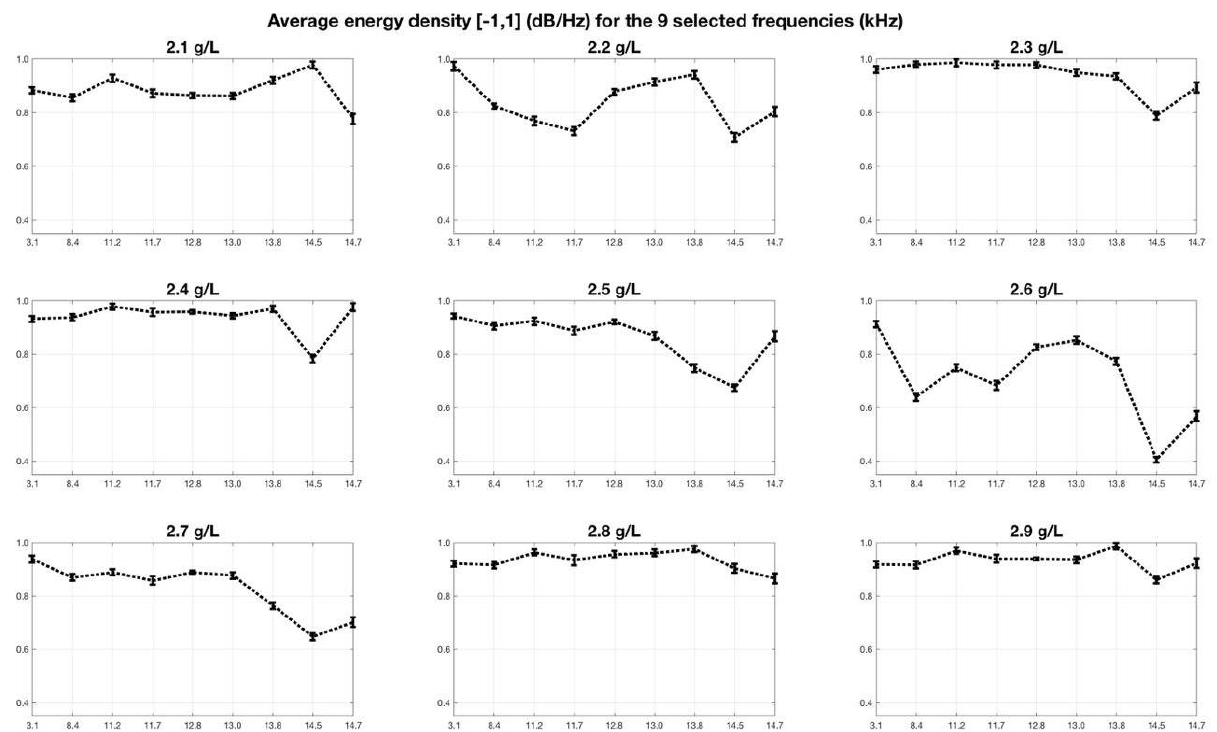
Figure 7. Spectral information patterns for fructose concentrations from 2.1 g/L to 2.9, with the average and normalized value of the sound pressure level (dB/Hz) as a function of the frequencies (kHz) used by the combined classifier.